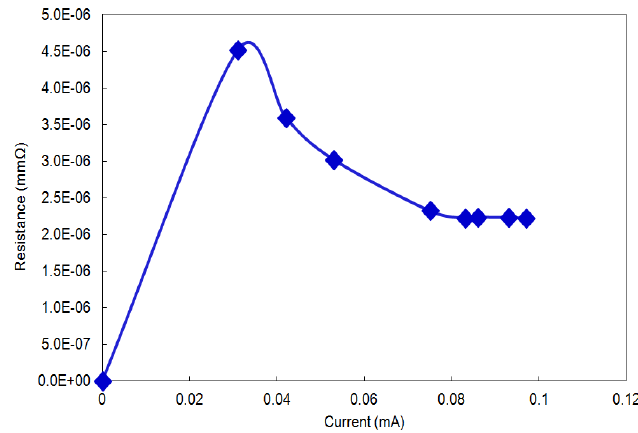
Figure 7. Resistance vs . current.